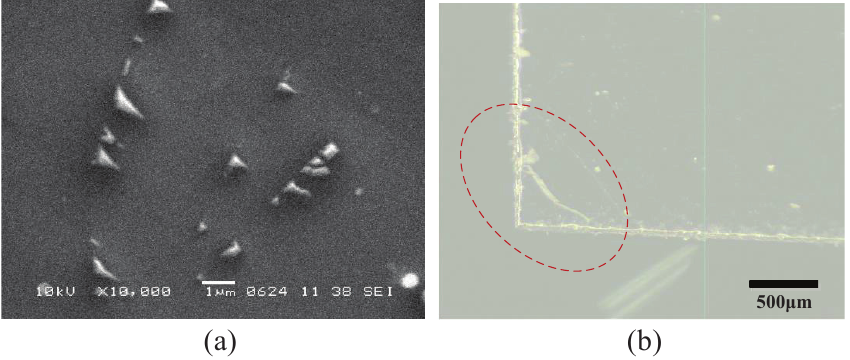
Figure 11. ( a ) SEM micrograph; and ( b ) photograph of the graphene film.